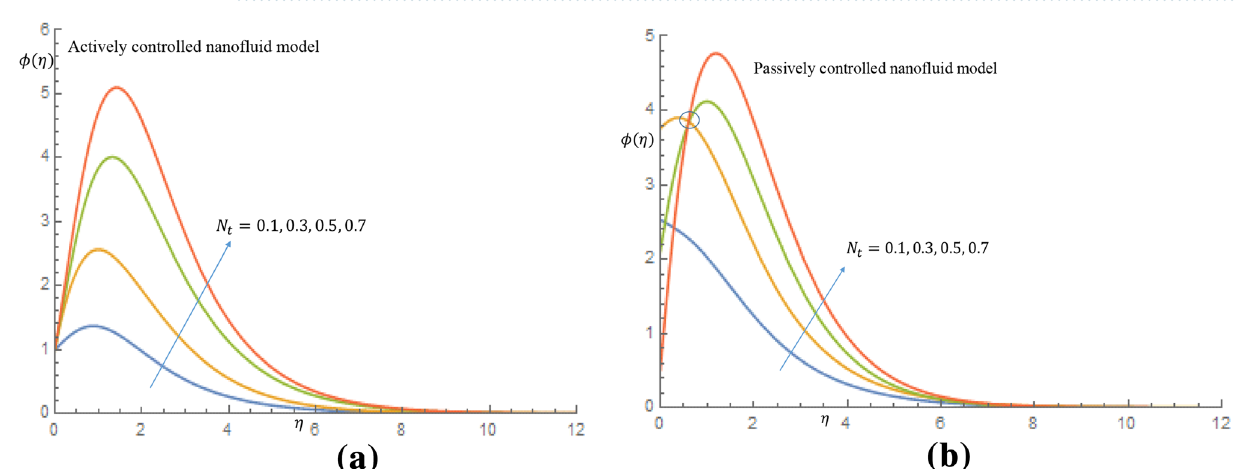
Figure 12. ( a ) Effect of N t on nanoparticles concentration profile when N b = 0.05 . ( b ) Effect of N t on nanoparticles concentration profile when N b = 0.05 .